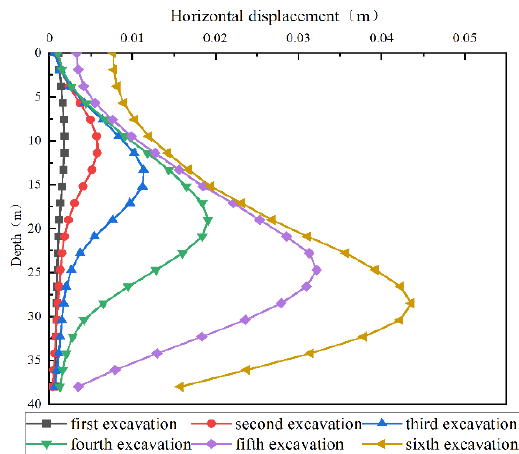
Figure 21. Horizontal displacement curve of foundation pit excavation enclosure structure with a seepage point at 0.001 m.